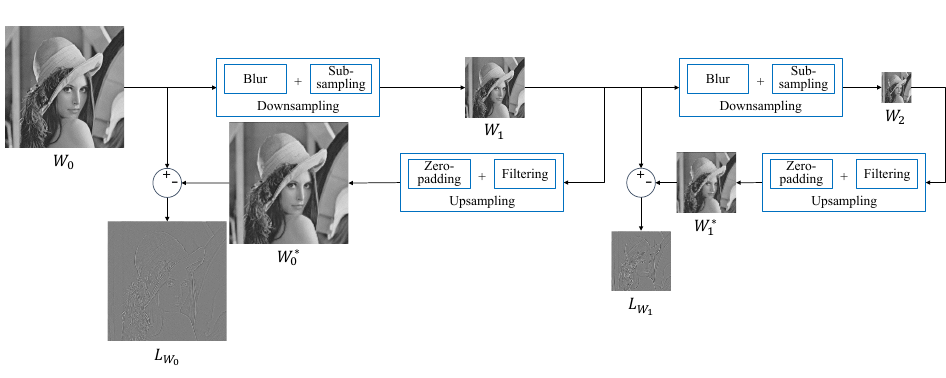
Figure 3. Outline of Laplacian pyramid decomposition with depth level l = 2.